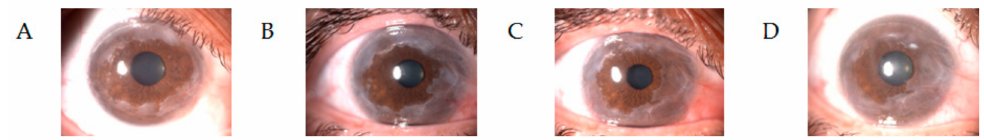
Figure 6. Images of corneal kappa light chain deposition disease. ( A ) Peripheral corneal deposits at diagnosis. ( B ) Three years later, the ocular examination revealed increased corneal involvement. ( C ) Picture taken before the autologous stem cell transplant (ASCT) showing stable disease ( D ) One year after ASCT, the patient achieved stringent complete response with stabilized corneal